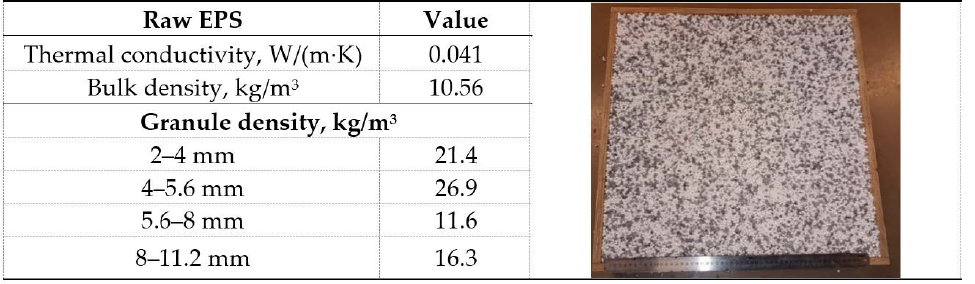
Figure 1. Appearance and macrostructure of different particle size EPS granules: ( a ) <1 mm; ( b ) 1–2 mm; ( c ) 2–4 mm; ( d ) 4–5.6 mm; ( e ) 5.6–8 mm; ( f ) 8–11.2 mm. Microstructure of EPS granules: ( g )